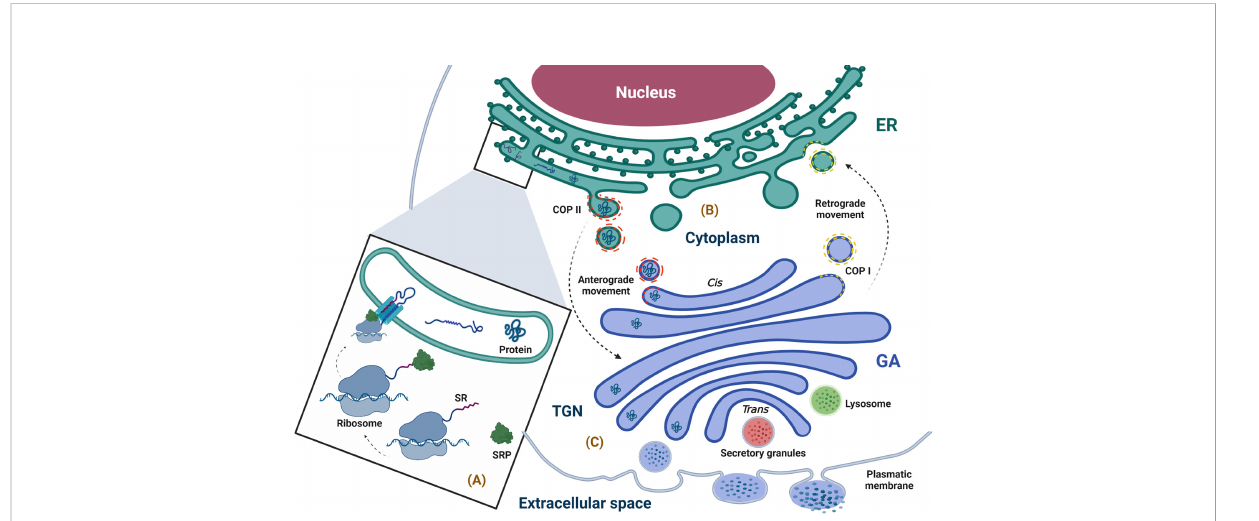
FIGURE 2 Physiological overview of the secretory pathway. (A) Synthesis, anchoring, and translocation of protein to the ER (ribosome binding to the ER membrane is promoted by the SRP complex, which recognizes the SR; once in the ER lumen, the ribosome – nascent protein complex, coupled to the translocon, translates the polypeptide into the lumen of the ER), (B) Protein folding and quality control (the newly synthesized proteins with correct folding and assembly continue their forward movement in COPII-coated vesicles that fuse with the GA for cargo delivery; however, the secretory pathway is bidirectional, and the circulatory pathway may stretch from the GA to ER, moving retrogradely through COPI-coated vesicles). (C) Protein sorting (when proteins arrive at the TGN, they are classi fi ed and packaged in transport vesicles to be sent to their fi nal destination, i.e., the extracellular space). ER, endoplasmic reticulum; GA, Golgi apparatus; SR, signal recognition; SRP, signal recognition particle; TGN, trans-Golgi network. The fi gure was created with BioRender.com (agreement no.